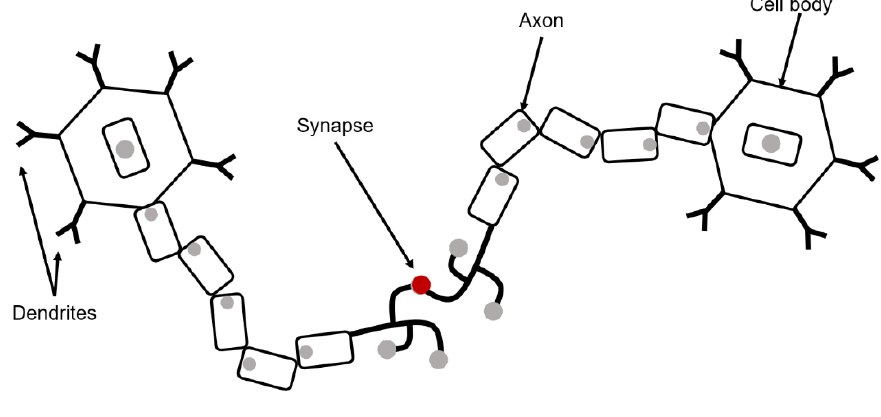
Figure 2. Structure of a biological neuron.